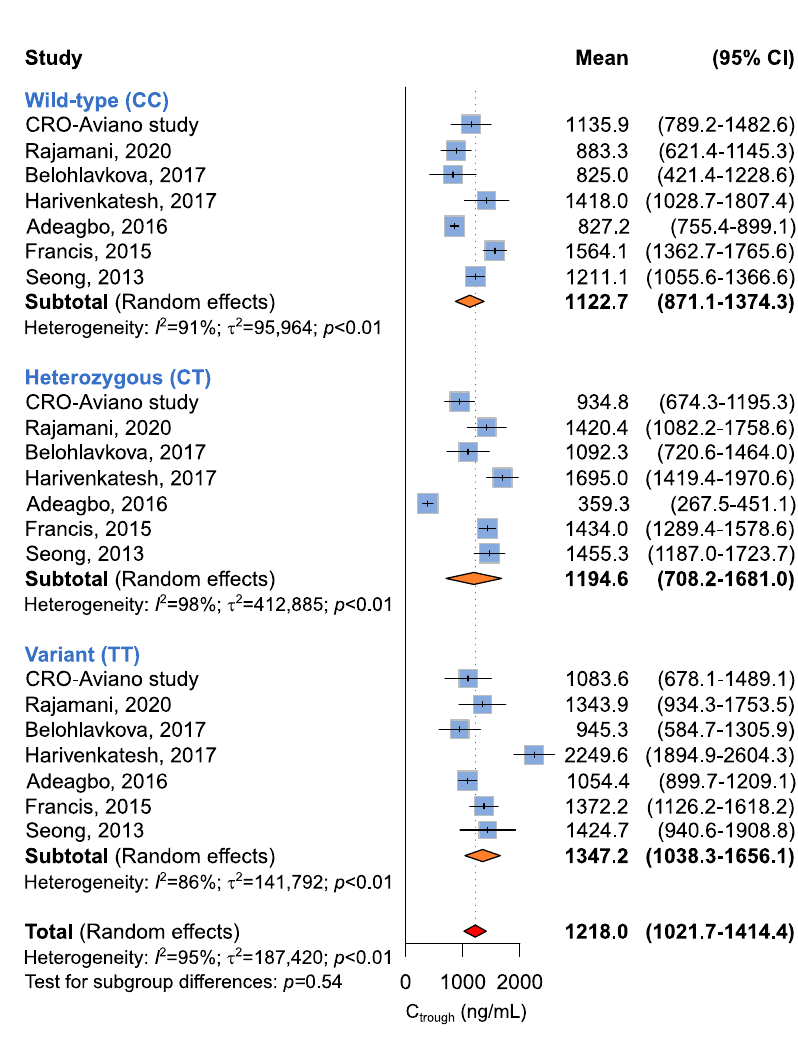
Figure 2. Forrest plots for the association between ABCB1 c.3435C>T and imatinib C trough levels for individual genotypes (allelic model) [14–19].